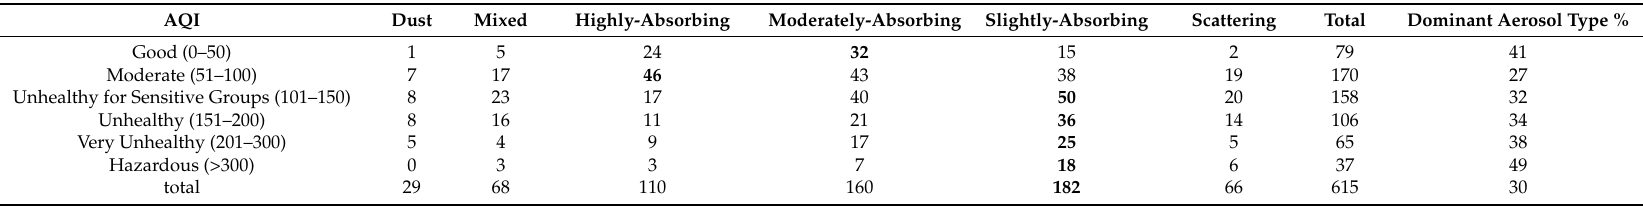
Table 3. The percentage of aerosol types in different air quality level (2013–2015) by the range groups of the daily average of AQI at the XH site. N = 615 (the values in bold are the days of the dominant aerosol